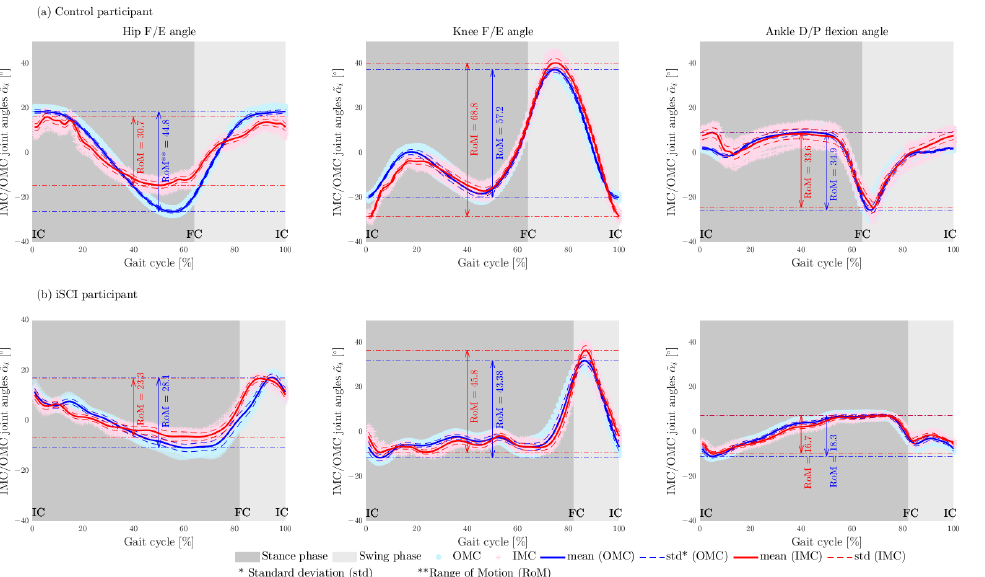
Figure 3. Exemples of RoM of the F/E hip angle, F/E knee angle, and D/P flexion ankle angle for ( a ) one control participant and ( b ) one iSCI participant walking on the treadmill. Red represents the IMU-based joint angles ˜ α i p t q , and blue represents the corresponding joint angles obtained from OMC system employing the plug-in gait model (used as a reference). The stance and swing phases are shaded by dark and light grey in the background. Initial contact and Final contact are marked as IC and FC in each plot.